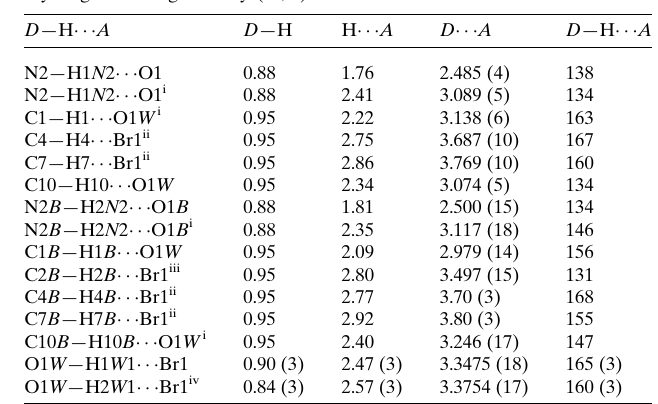
Table 1 Hydrogen-bond geometry (A˚ , (cid:5) ).